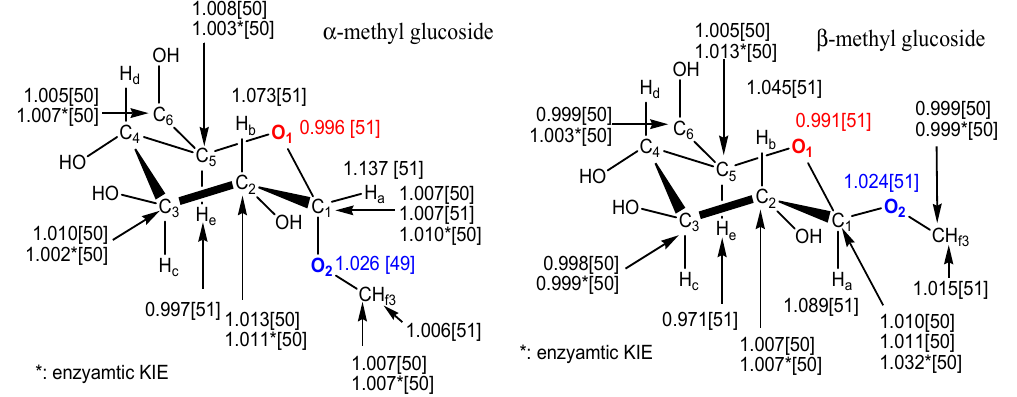
Figure 3. Observed 2 H-, 13 C-, and 18 O-KIEs for methyl glucosides measured by NMR spectroscopy extracted from refs